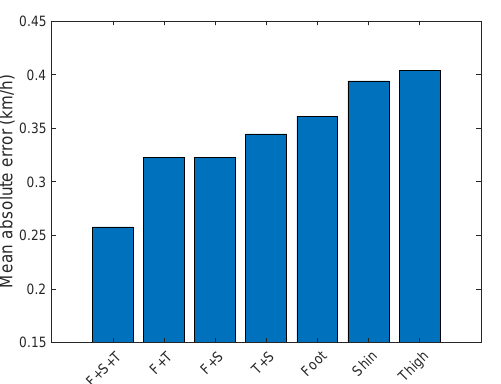
Figure 7. The average error of speed prediction of the SVAE-Sine method trained data from IMU sensors at different locations and their